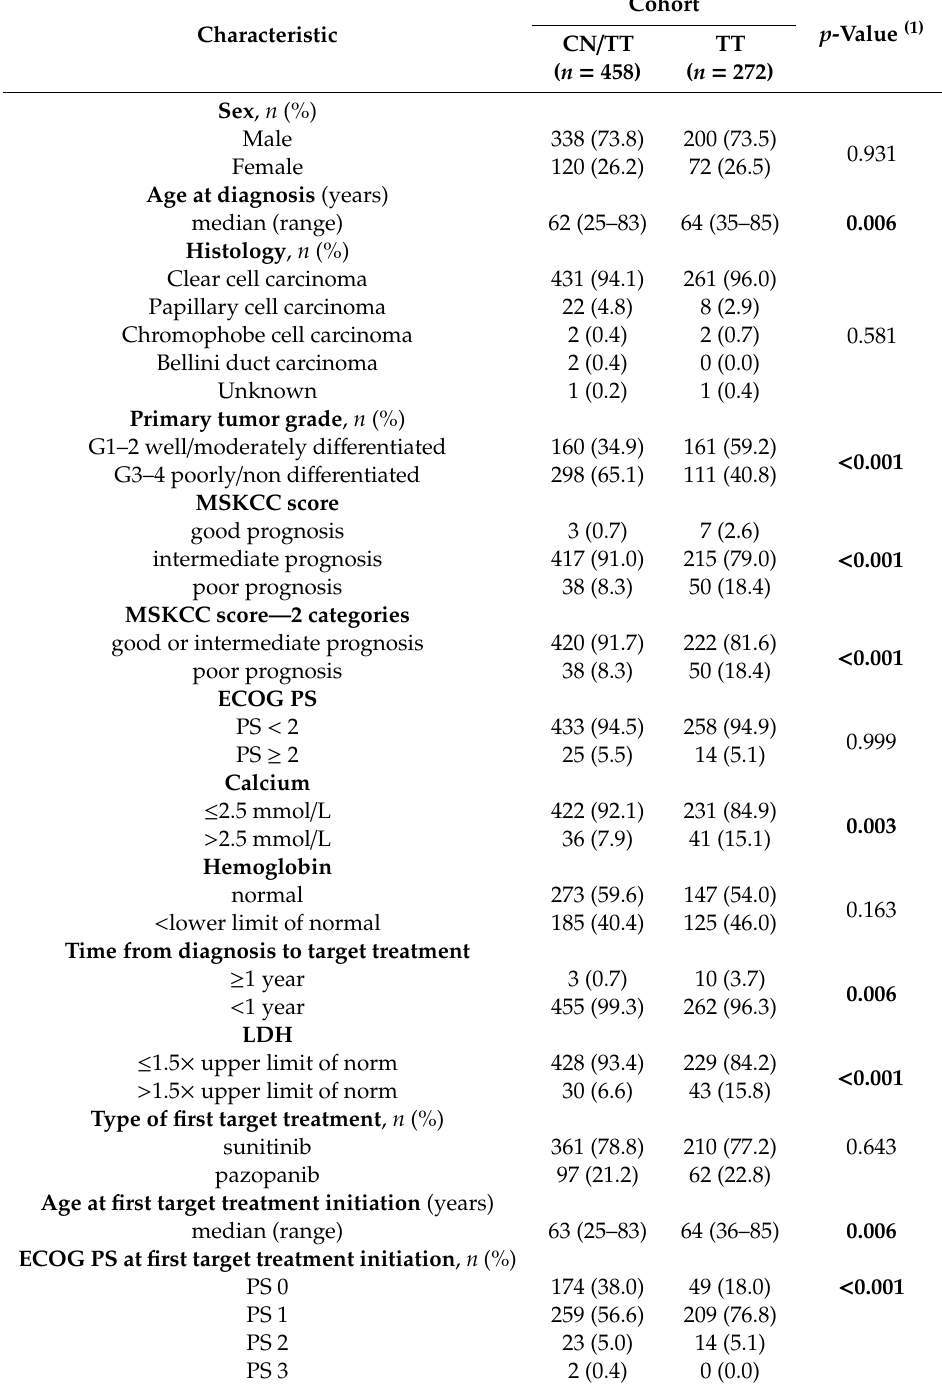
Table 1. Baseline patient’s